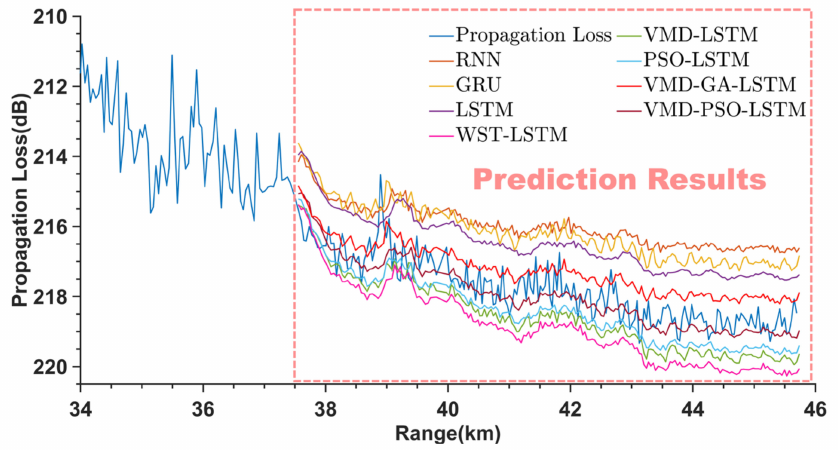
Figure 14. Prediction results of the first set of PL for different methods.